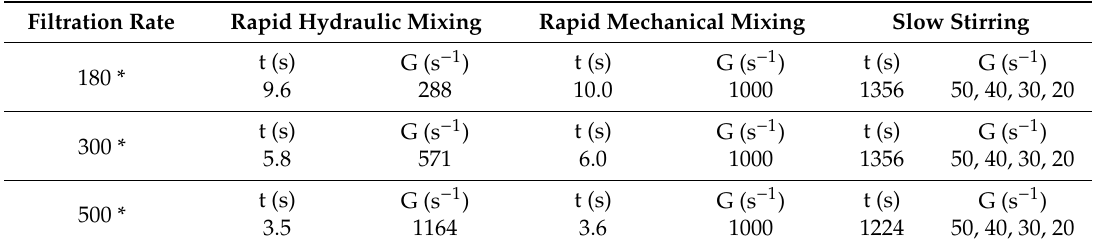
Table 5. Operational conditions at pilot Water Treatment Plant.